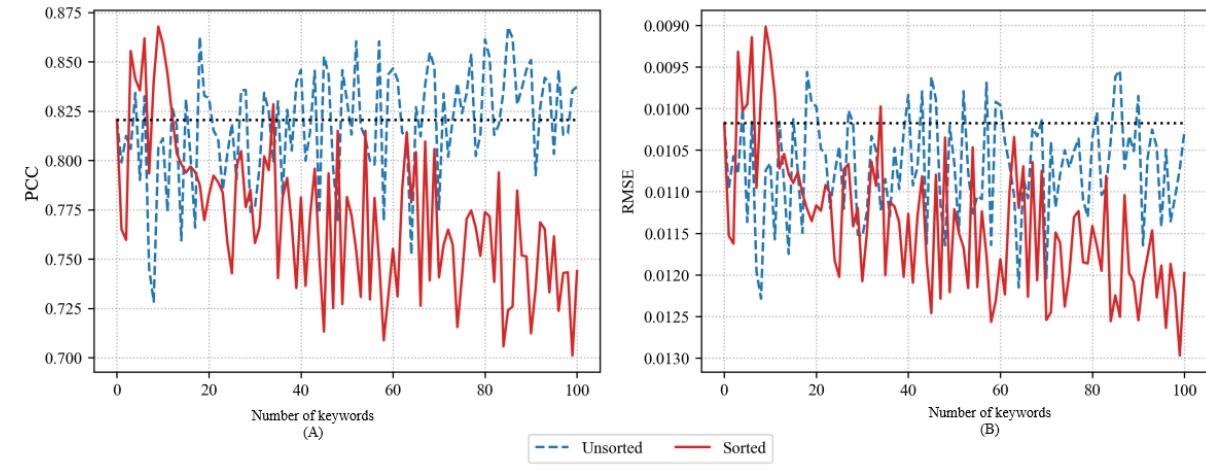
Table 3. Pearson correlation coefficient (PCC) and root-mean-square error (RMSE) for influenza prediction models using different word embedding techniques.